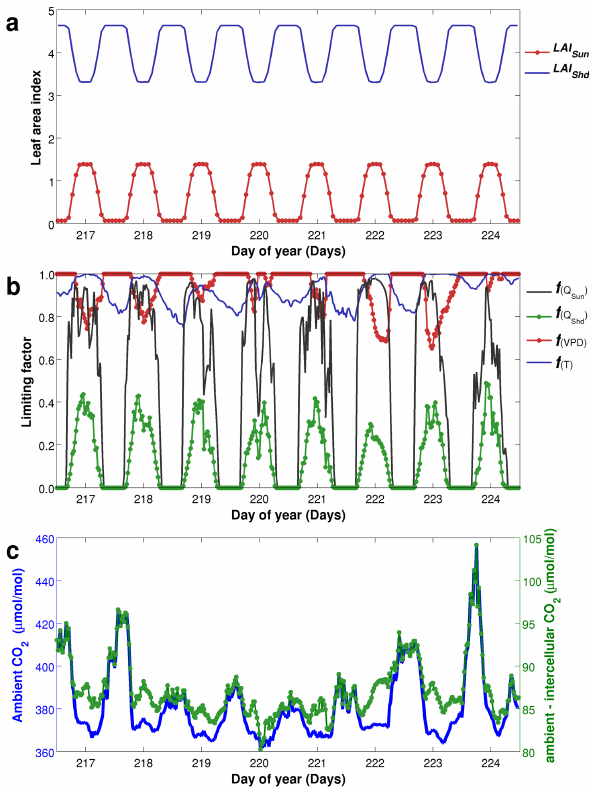
Figure 5. Time series of components of the photosynthesis calcu- lation shown for (a) sunlit and shaded leaf area index; (b) environ- mental limiting factors imposed by radiation absorption, tempera- ture, and vapor pressure deficit; and (c) CO 2 concentration. Data are shown from DOY 217 to 224 in 2004 for the US-Bar site.